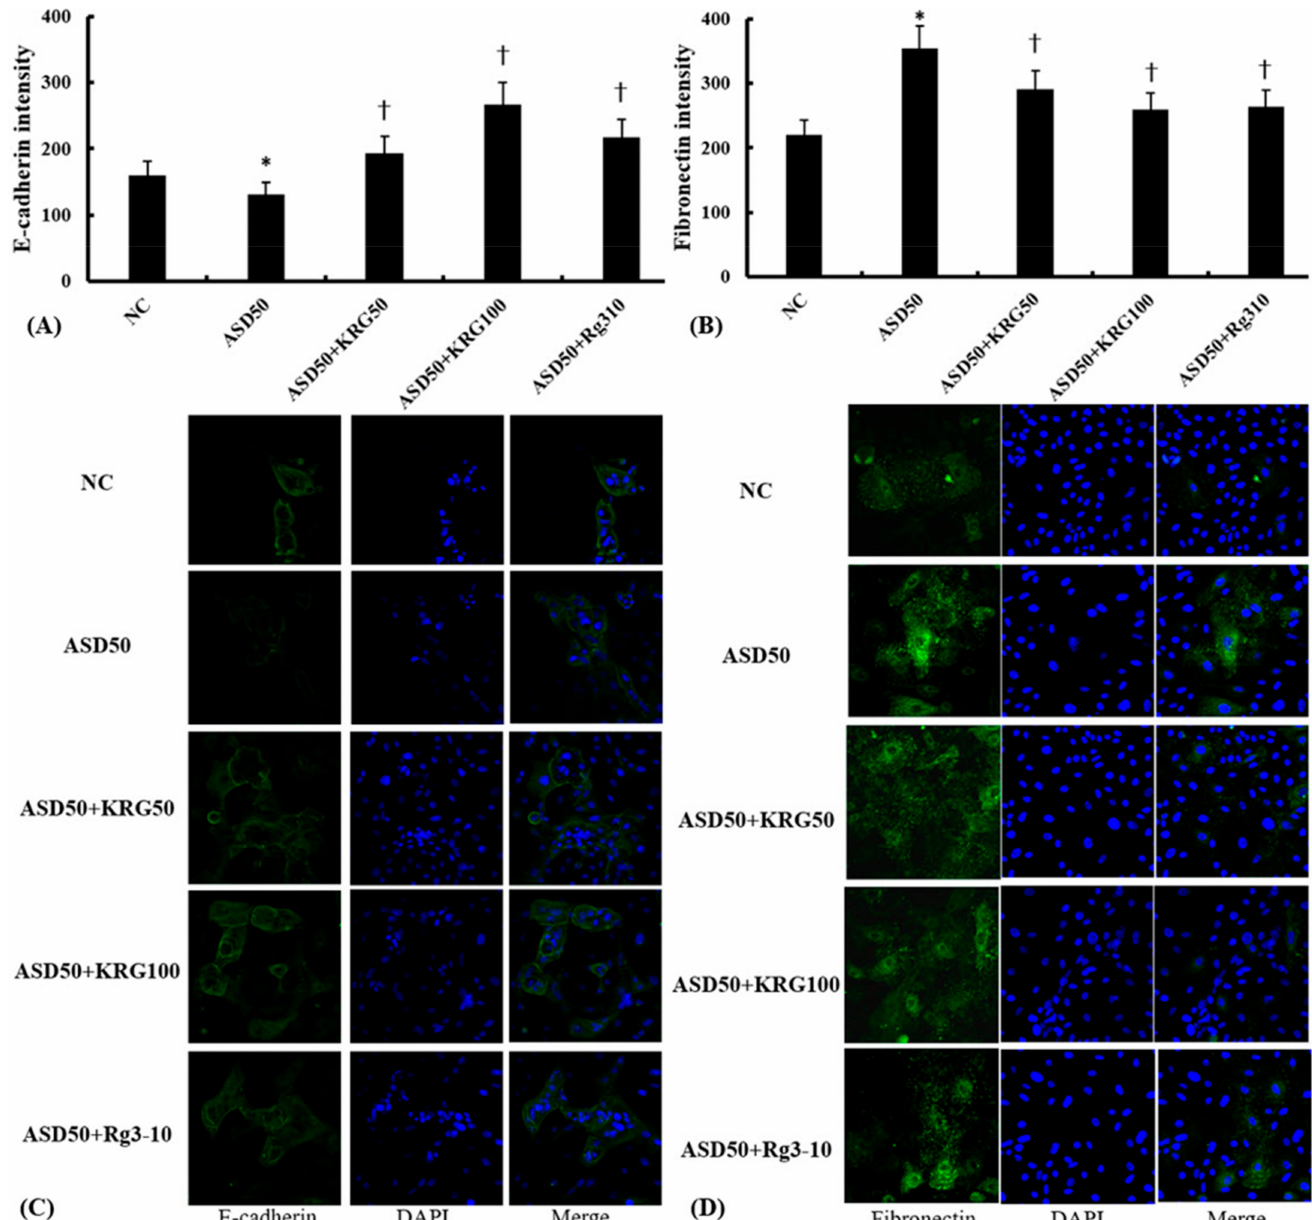
Figure 3. Effects of Korean red ginseng (KRG) and ginsenoside Rg3 on Asian sand dust (ASD)- induced E-cadherin and fibronectin immunofluorescence intensity in nasal epithelial cells. KRG (50 and 100 µ g/mL) and Rg3 (10 µ g/mL) suppressed the ASD (50 µ g/mL)-induced downregulation of E-cadherin ( A ) and the upregulation of fibronectin ( B ) expression in nasal epithelial cells. ( C , D ) show representative fluorescein immunofluorescence images with EMT markers (green) and nuclear DAPI (blue). NC: negative control (NC means nasal epithelial cells were not treated with ASD, KRG, or Rg3). *: p < 0.05 compared with NC. †: p < 0.05 compared with the ASD-stimulated group, n =